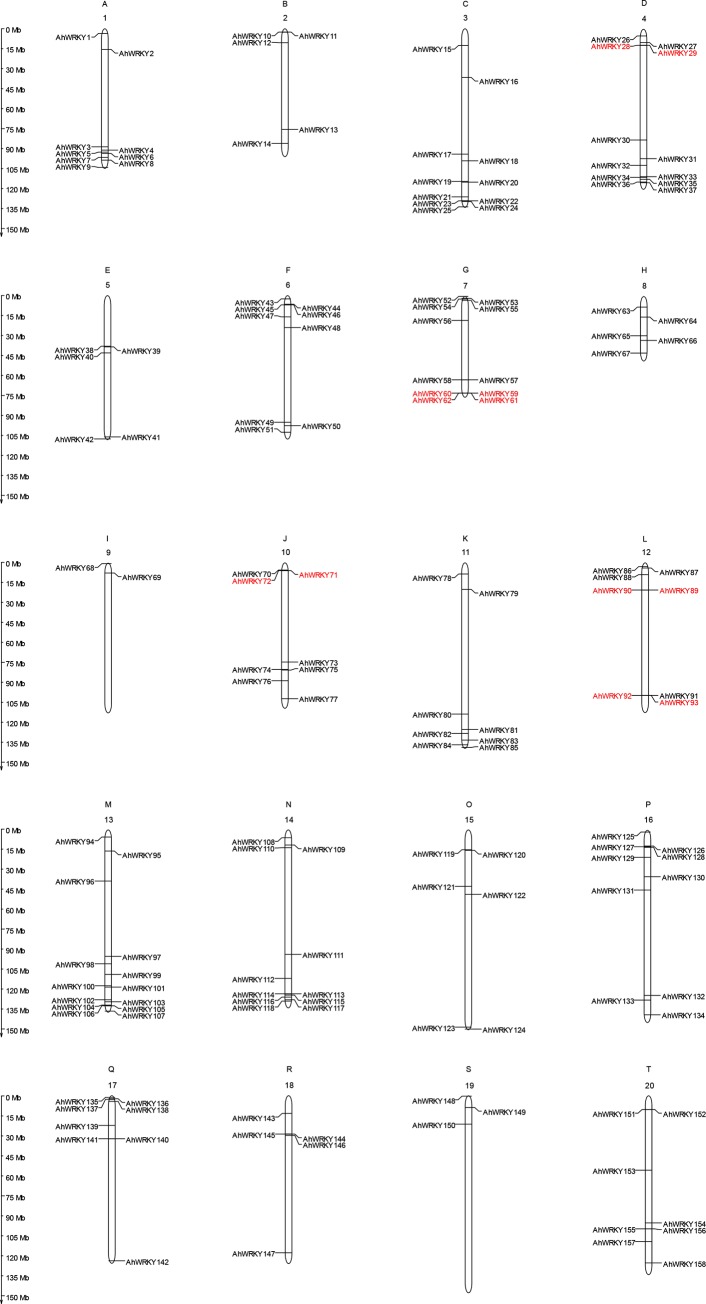
Physical mapping of AhWRKY genes on chromosome.The chromosome numbers were indicated at the top of each chromosome. The scale is in megabases (Mb). Tandem duplication genes were marked in red.